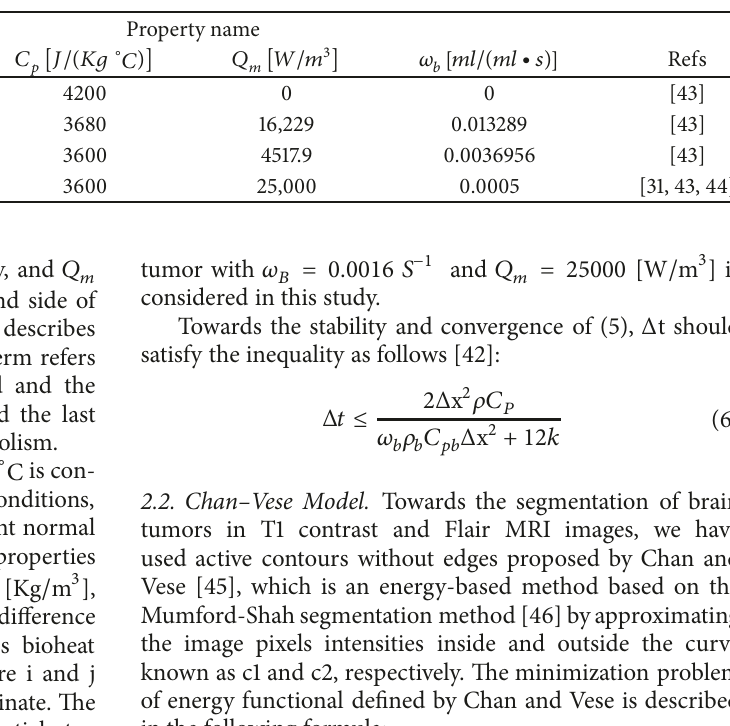
Table 1: Thermal properties used for temperature